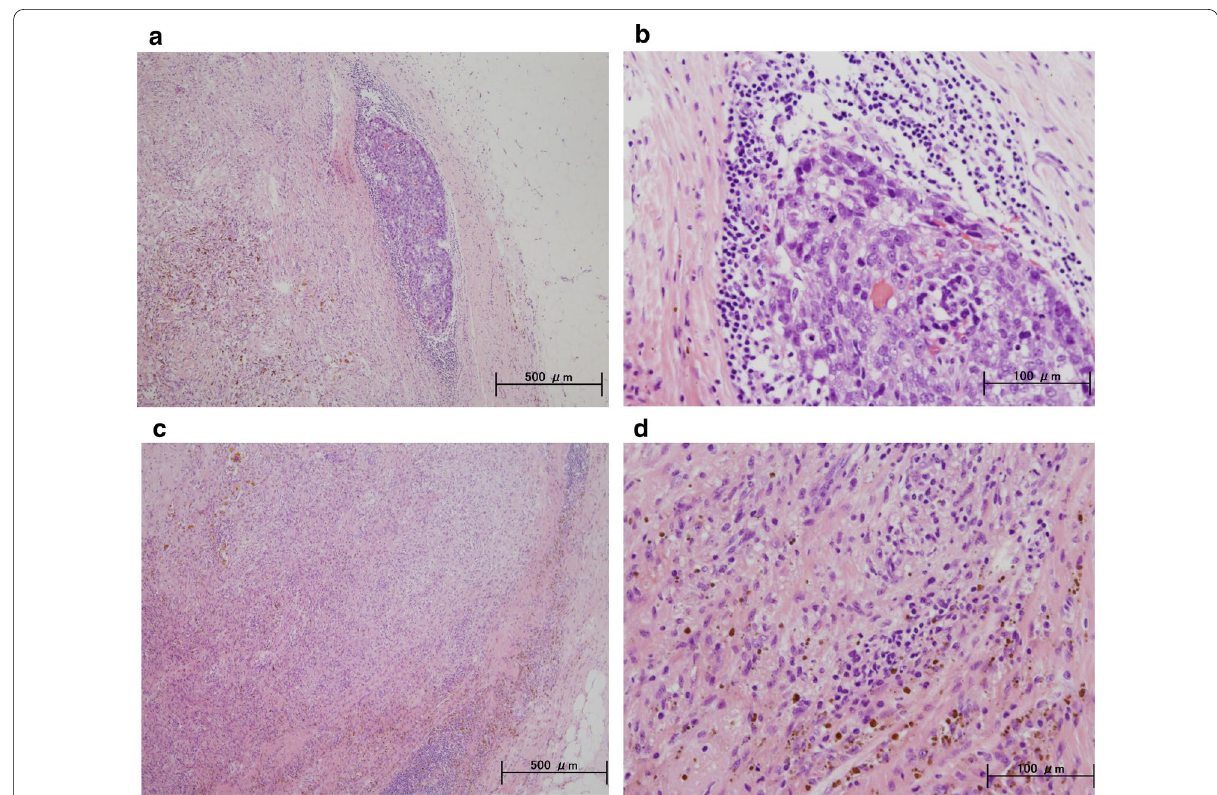
Fig. 4 Postoperative histopathological findings. Histopathological findings of the resected breast tissue ( a , c : hematoxylin and eosin (HE) HE 200). The tumor shows lymphocyte infiltration, coagulation necrosis, and fibrous tissue with hemosiderin ×